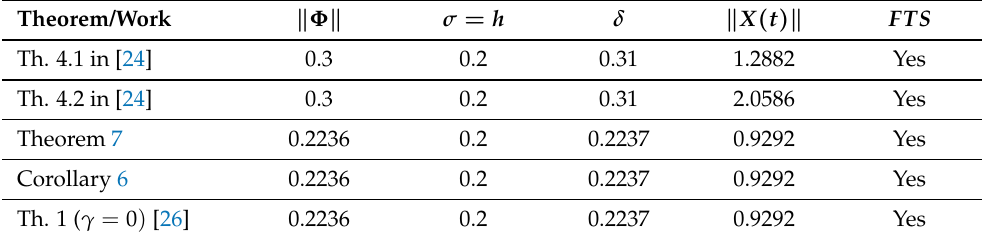
Table 1. Compared